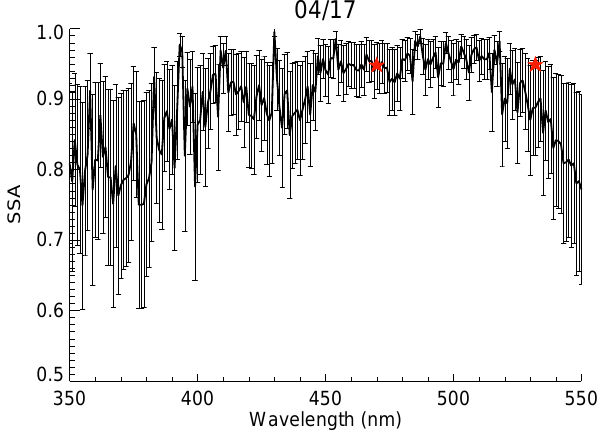
Fig. 3. Retrieved in-plume average SSA for 17 April. Error bars represent the standard deviation of all retrieved in-plume SSA val- ues. Orange stars represent SSA calculated from measured b scat and b abs . Maximum and minimum SSA values measured for the plume are shown by orange error bars. For 17 April, maximum and mini- mum SSA values were close for both wavelengths (Ranges: 0.946– 0.951 (470nm) and 0.947–0.952 (532nm)) and thus are not visible on the graph.